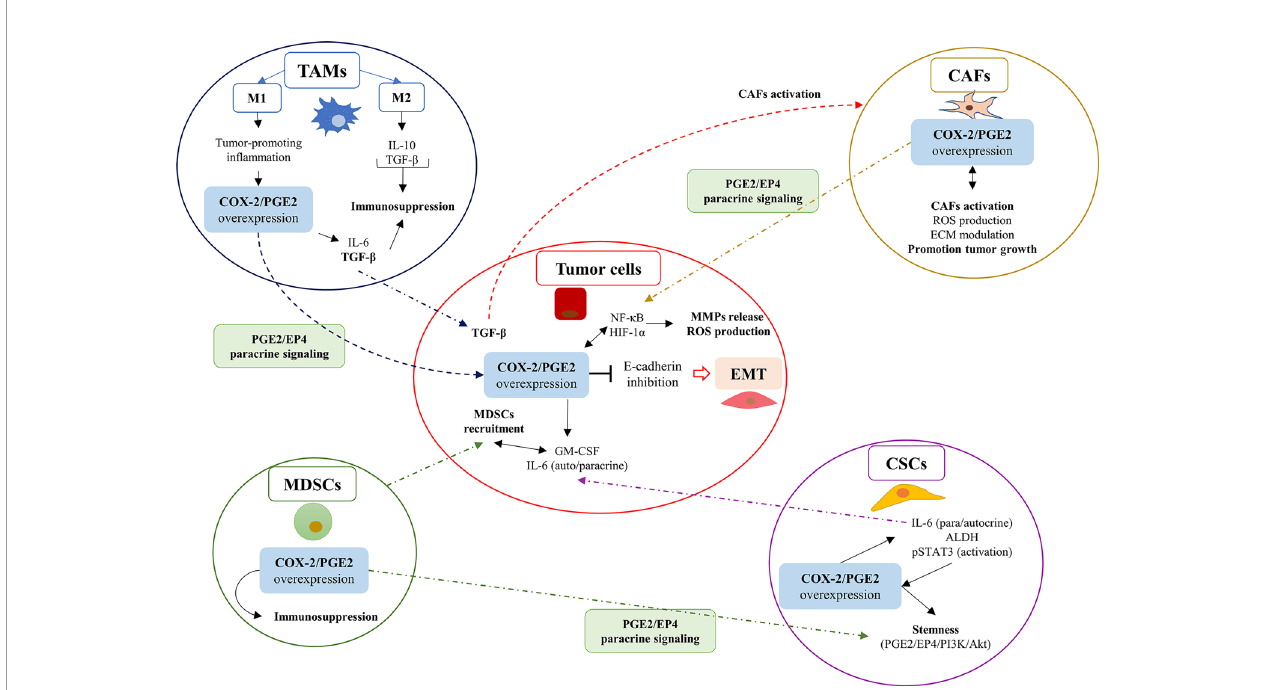
FIGURE 2 | The overexpression of the COX-2/PGE2 axis in cells within the tumor microenvironment (TME) promotes EMT in tumor cells through PGE2/EP4 paracrine signaling. The overexpression of the COX-2/PGE2 axis in cells within the TME promotes EMT in tumor cells through PGE2/EP4 paracrine signaling. The COX-2/PGE2 axis overexpression favors the EMT phenomenon in tumor cells as a consequence of the inhibition of E-cadherin expression. The COX-2/PGE2 overexpression promotes signaling related to ROS and hypoxia, which explains the in fl ammatory pro fi le of the tumor microenvironment (TME) in solid tumors. Carcinoma-associated fi broblasts (CAFs); cancer stem cells (CSCs); myeloid-derived suppressor cells (MDSCs); and tumor-associated macrophages